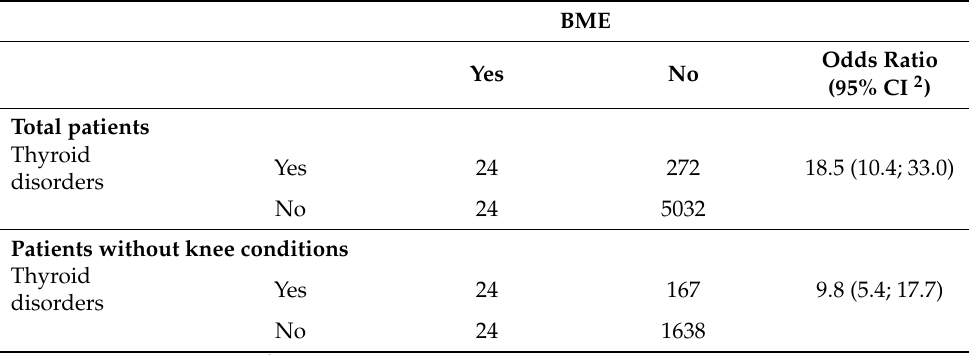
Table 4. Association of BME 1 and thyroid